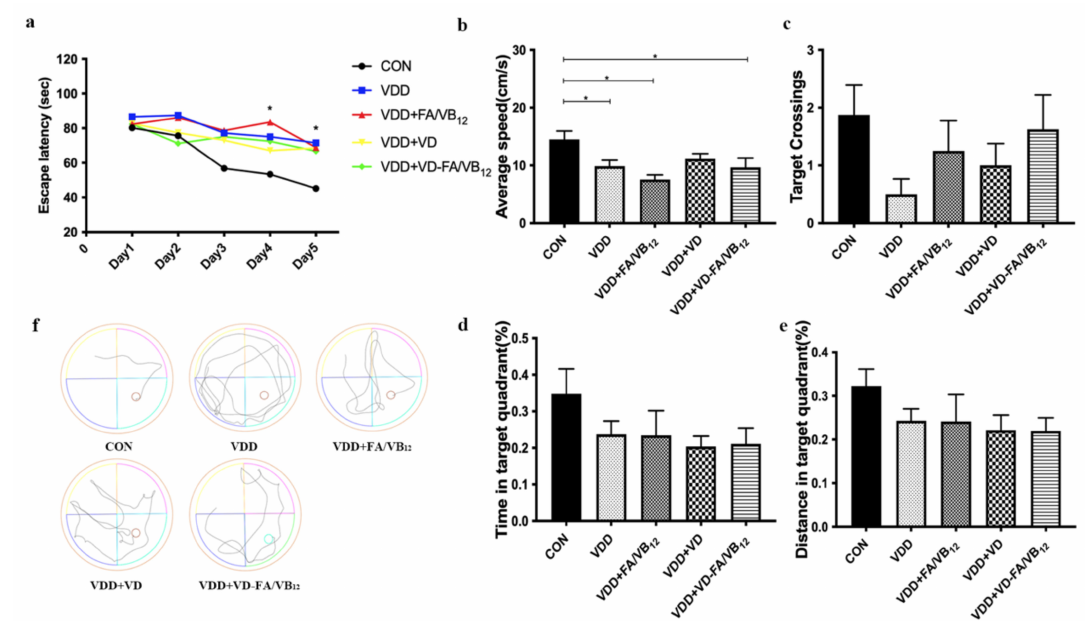
Figure 2. Spatial learning and memory ability in mice via Morris water maze. ( a ) Escape latency; ( b ) Average speed; ( c ) Number of platform-site crossovers; ( d ) Time in the target quadrant; ( e ) Dis- tance in the target quadrant; ( f ) Tracks of probe trial. CON: control; VDD: vitamin D-deficient diet; VDD + FA/VB 12 : vitamin D-deficient diet plus folic acid/vitamin B 12 supplement; VDD + VD: vitamin D-deficient diet plus vitamin D supplement; VDD + VD-FA/VB 12 : vitamin D-deficient diet plus vitamin D and folic acid/vitamin B 12 . All data are presented as the mean ± SEM ( n = 8). A two-sided p < 0.05 was considered statistically significant.